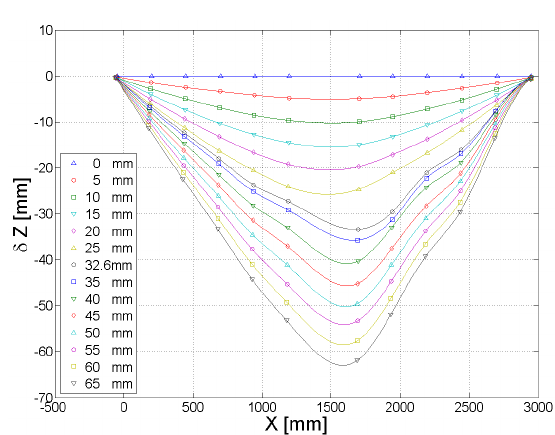
Figure 10. Cubic spline plots of the beam deflections for the second experiment using the photogrammetric reconstruction